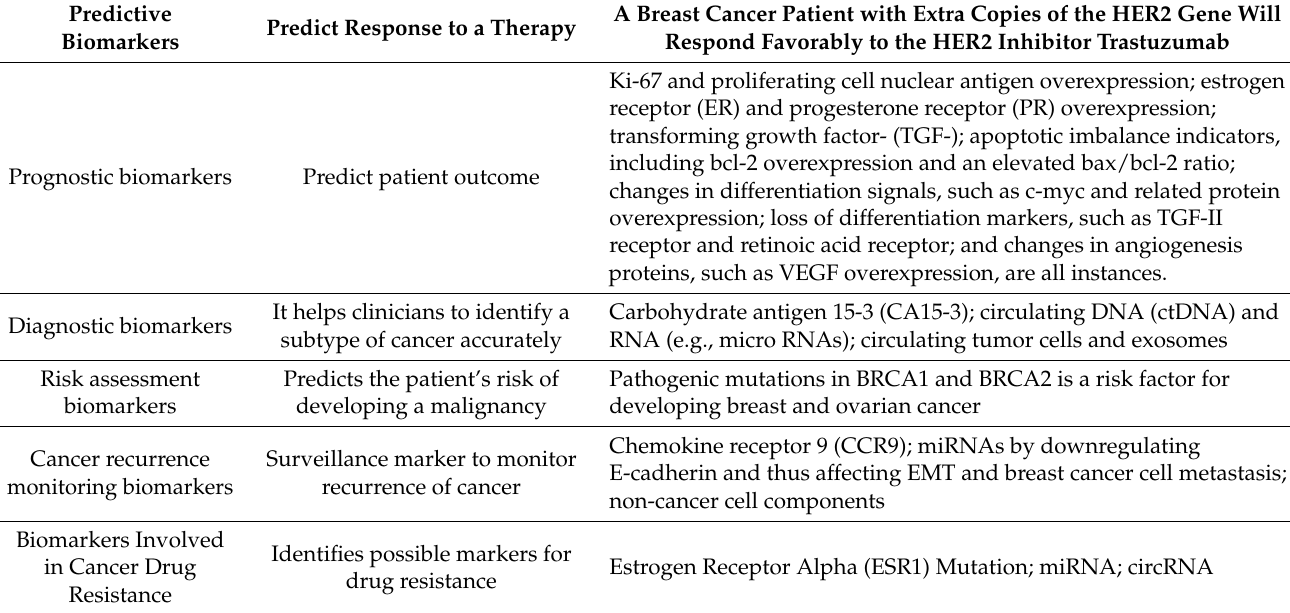
Table 3. Biomarkers classified into categories, and examples of each category for breast